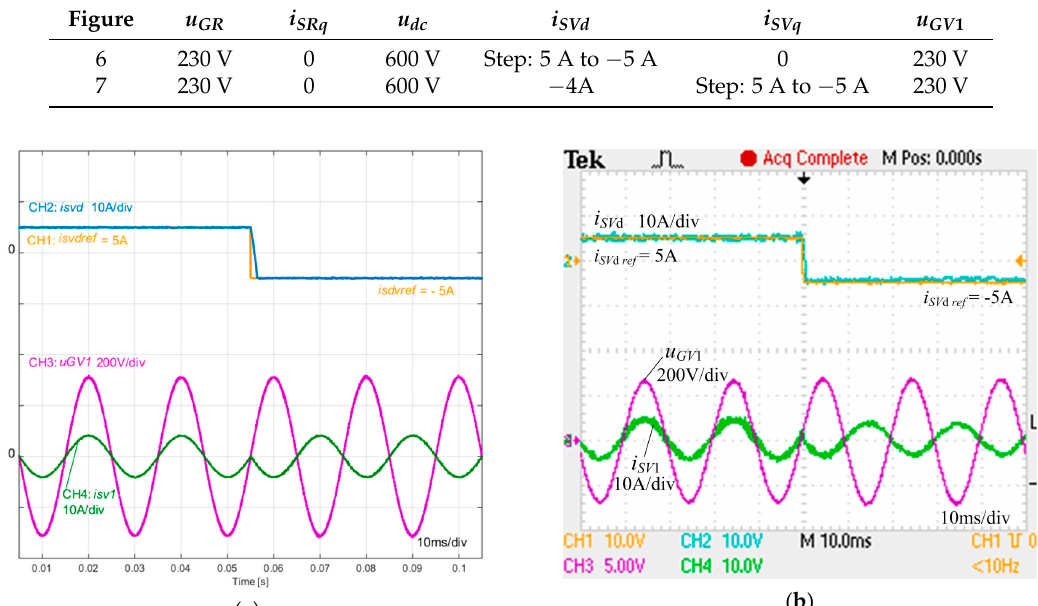
Figure 5. Phase current control experimental result. CH1: i SV 1 , 10 A/div, 20 ms/div; M: i SV 1 frequency spectrum, 100 mA/div, 1.25 kHz/div.